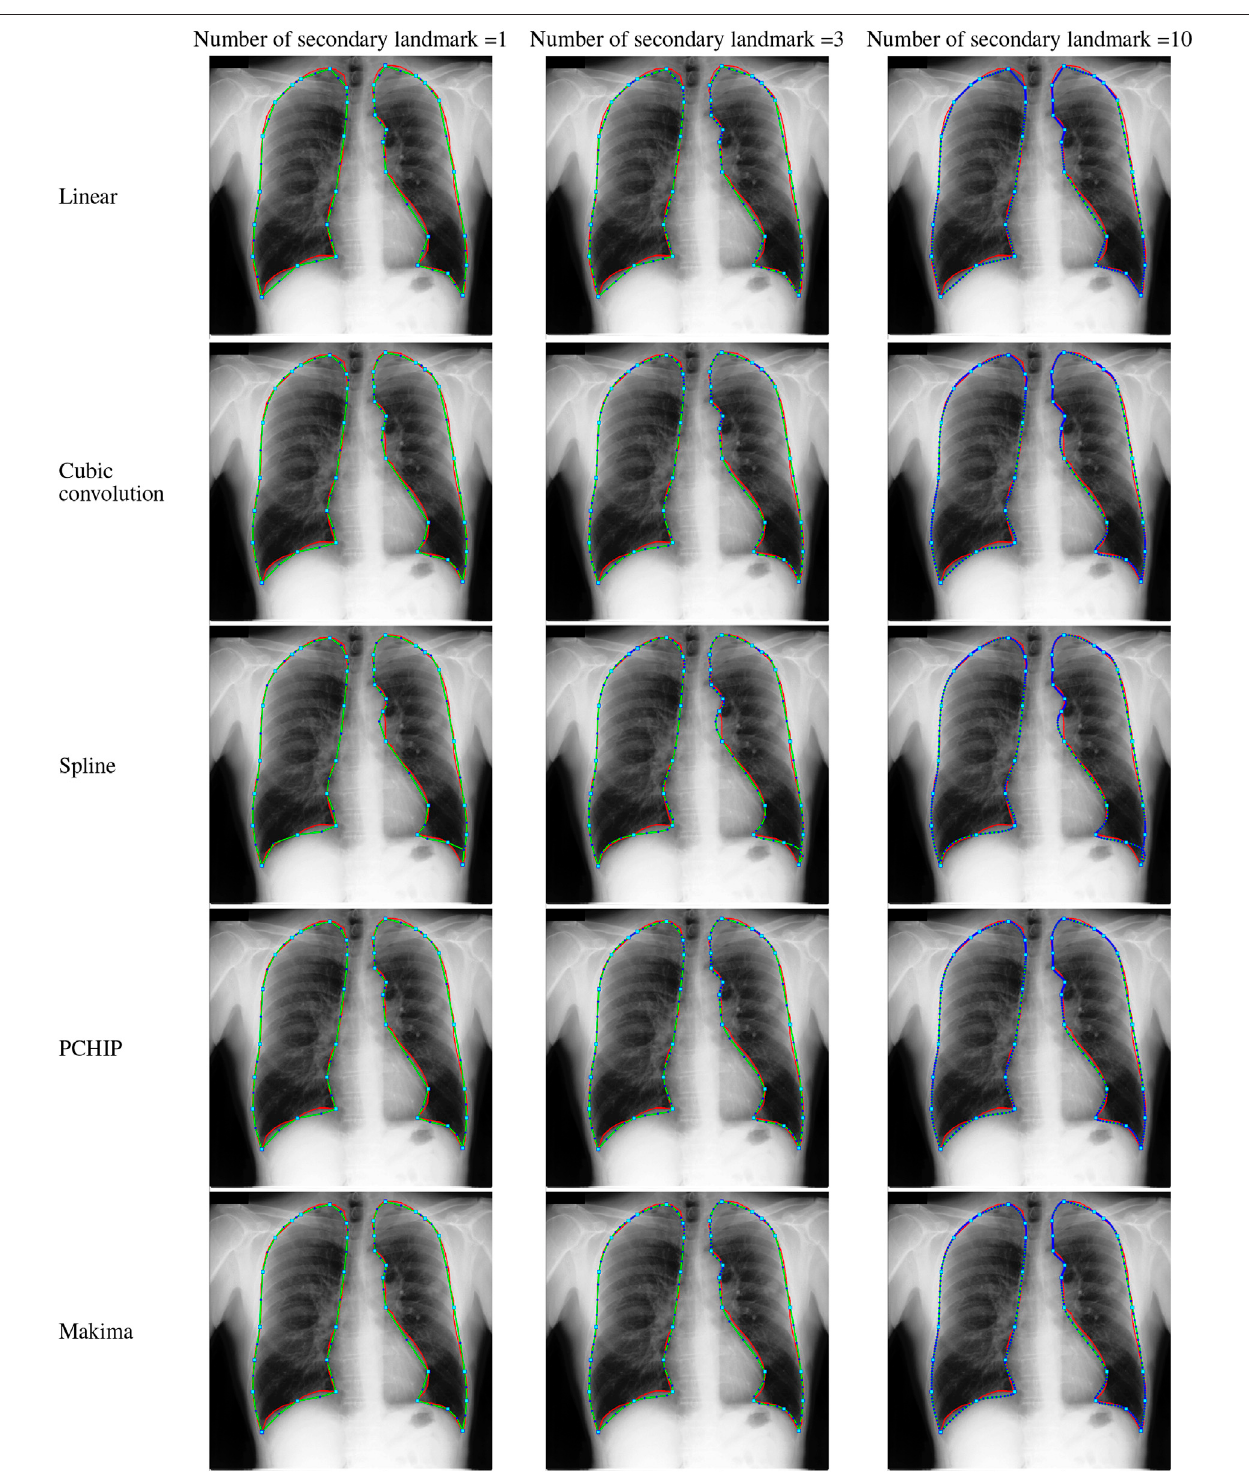
FIGURE 2 | Lungs region formation: ground truth (red) and the modeled shape (green) using different interpolating polynomials with 1, 3, and 10 intermediate semilandmark point(s) of the selected image dataset JPCLN001.